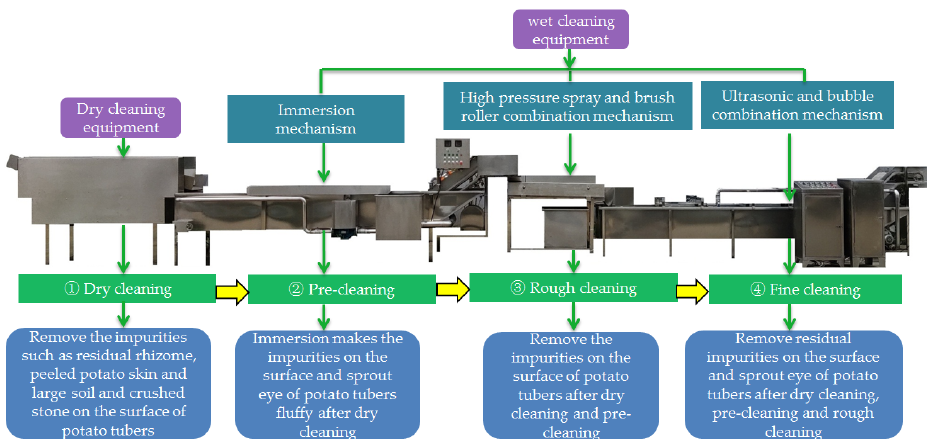
Figure 2. Overall process flow of cleaning method.